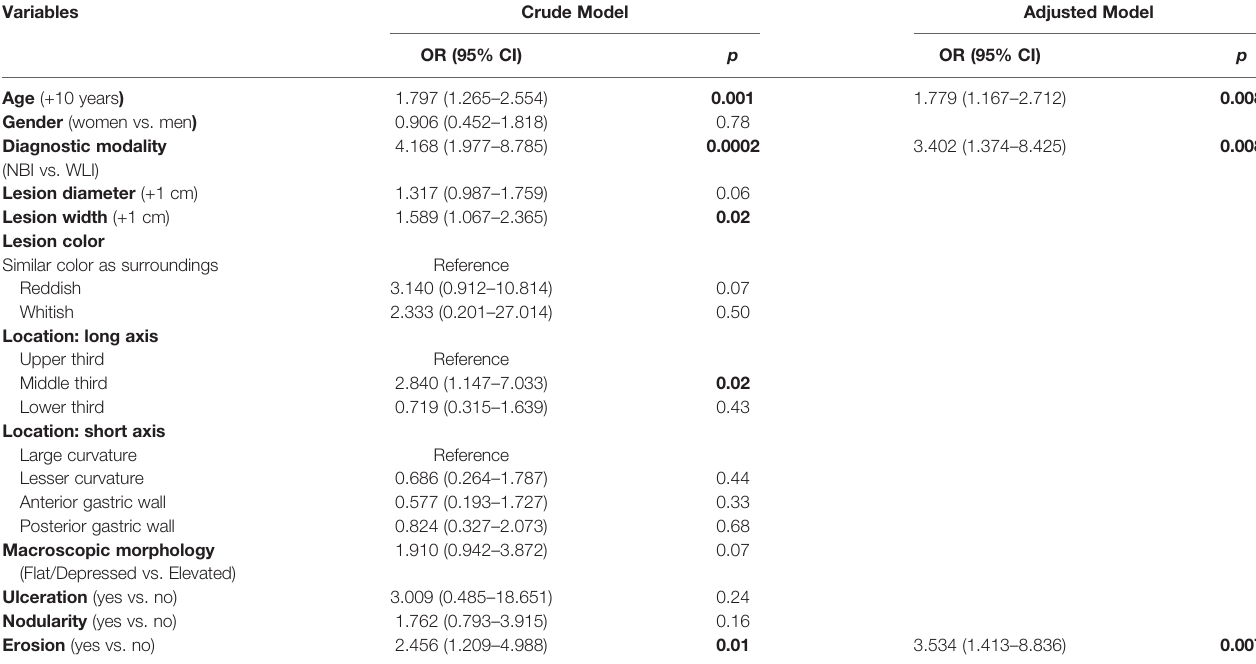
TABLE 2 | Multi-variable logistic regression analysis of risk factors for the upgraded group.